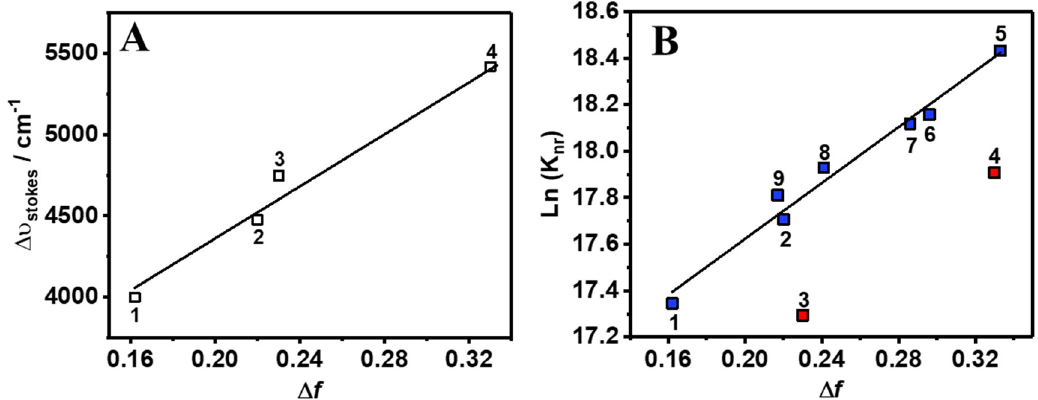
Figure 2. ( A ) Lippert–Mataga plot showing the dependence between the Stokes shift ( Δν Stokes ) and solvent orientation polarizability ( ∆ f ), and ( B ) show the dependence of Ln(k nr ) with ∆ f of all the solvents except DCM (3) and ACN (4), which are shown as red squares. The labeling of the solvent is shown in Table 1. Graph ( A ) was lineally fitted to y = 8397x + 2683, with R 2 = 0.97, n = 4, S.D. slope = 907 and S.D. (intercept) = 220. Graph ( B ) was lineally fitted to y = 6.01x + 16.4, with R 2 = 0.97, n = 7, S.D. slope = 0.40 and S.D. (intercept) = 0.10.